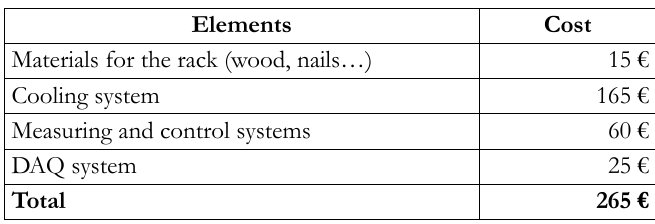
Table 2. Approximate cost of the laboratory equipment